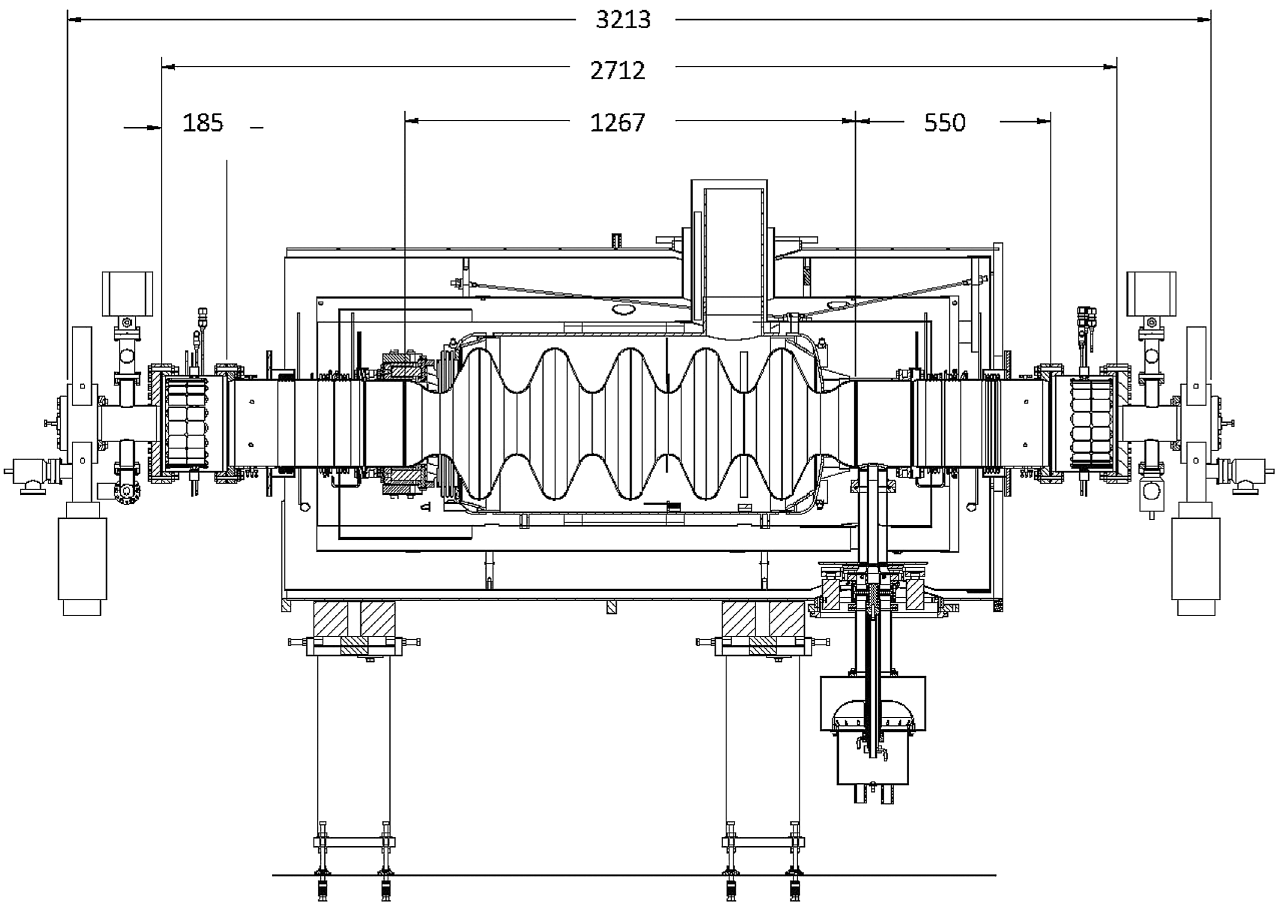
FIG. 2. The cross section of the ECX five-cell cavity vacuum string assembly (dimensions are in mm).